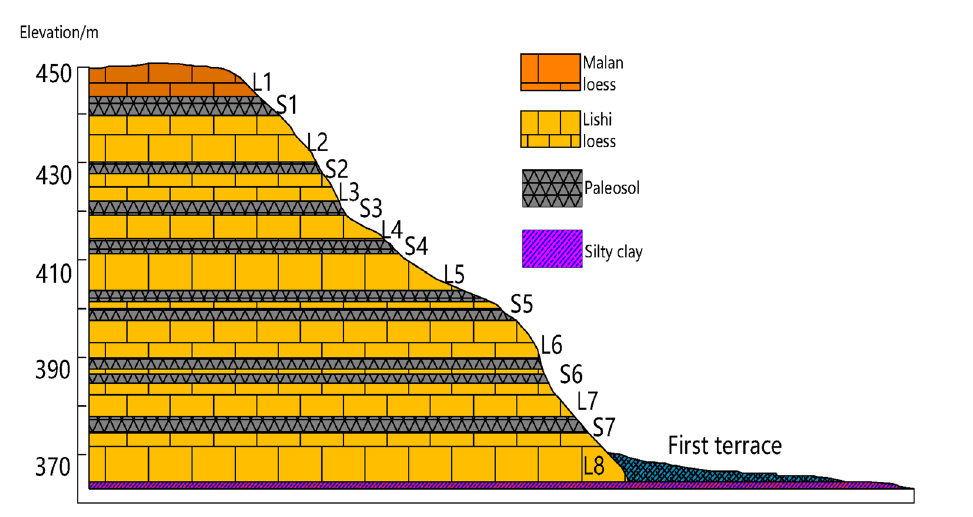
Figure 2. Vertical section of the stratum